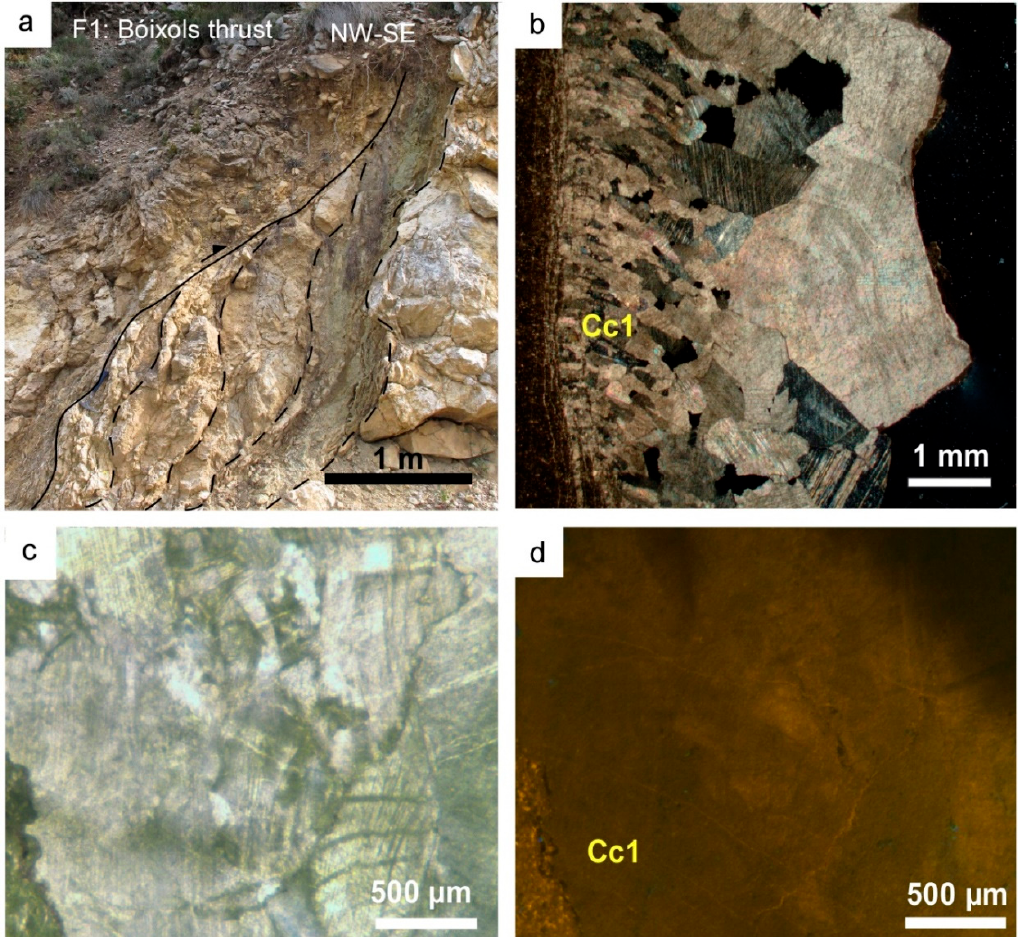
Figure 7. ( a ) Outcrop of the Bóixols thrust (F1) ( b ) Cc1 showing both calcite elongate blocky crystals grown in the same fracture (sample CN 33). ( c , d ) Calcite cement Cc1 seen in polarized optical microscope and cathodoluminescence (CL), respectively (sample CN27).